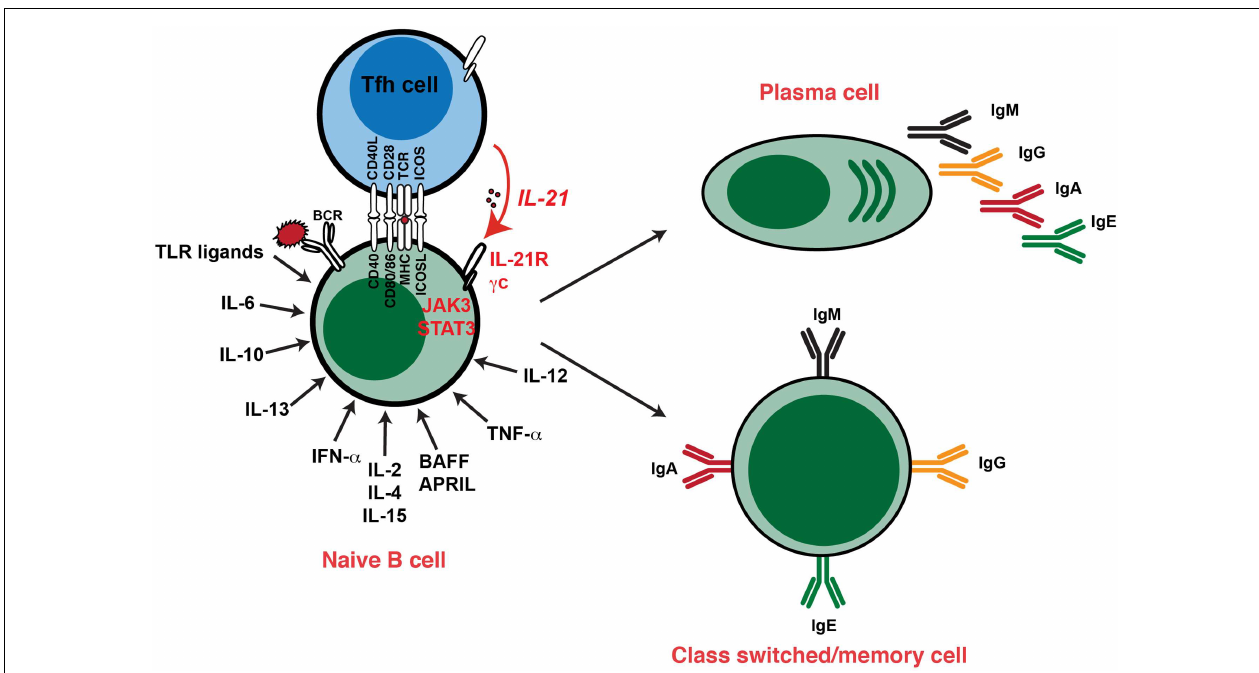
memory B cells and the establishment of Ag-specific Abs in vivo .Thus, although cytokines such as IL-4, IL-13, IL-10, and BAFF/APRIL are strong B-cell growth and differentiation factors, their function is insufficient to compensate for impaired IL-21/IL-21R signaling in vivo in the setting of generating robust, long-lived Ag-specific Ab, and memory responses. Consequently, IL-21-mediated B-cell activation is a necessary and sufficient step in the generation of protective long-lived humoral immune responses in